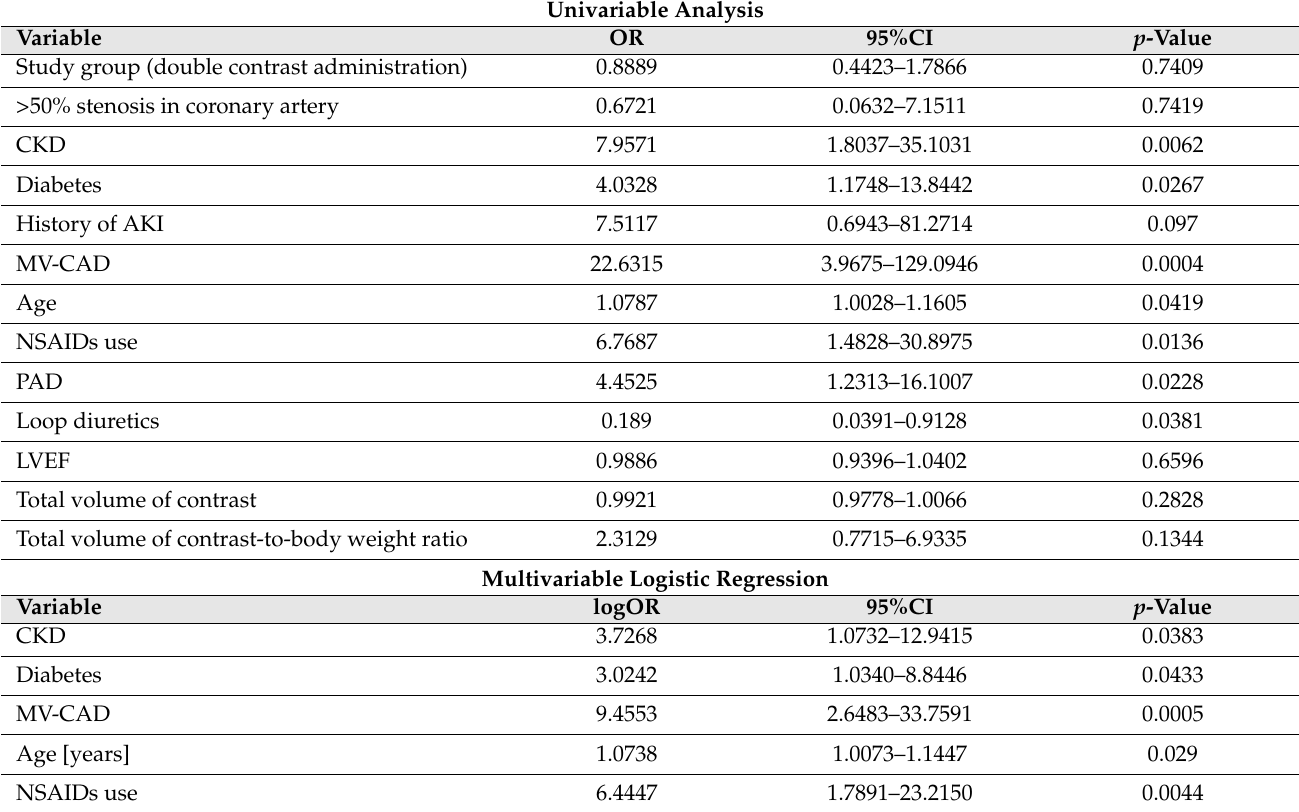
Table 3. Univariable and multivariable logistic regression analysis of different predictors of the onset of contrast-induced acute kidney